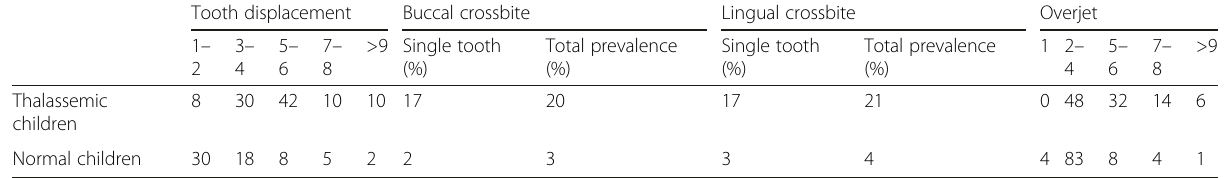
Table 2 Comparison of prevalence of tooth displacement, buccal and lingual crossbite, and overjet in thalassemic and normal